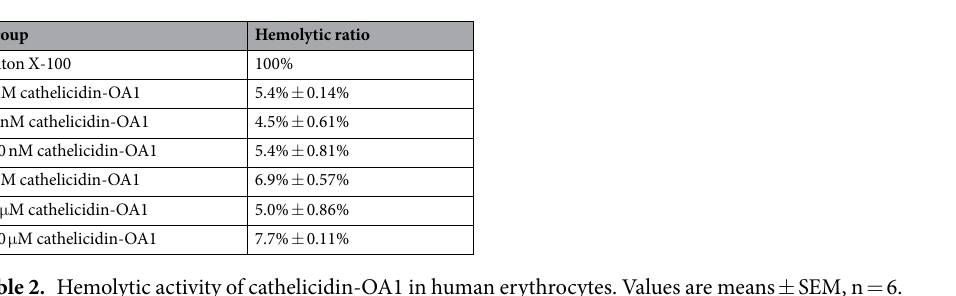
Table 2. Hemolytic activity of cathelicidin-OA1 in human erythrocytes. Values are means ± SEM, n =